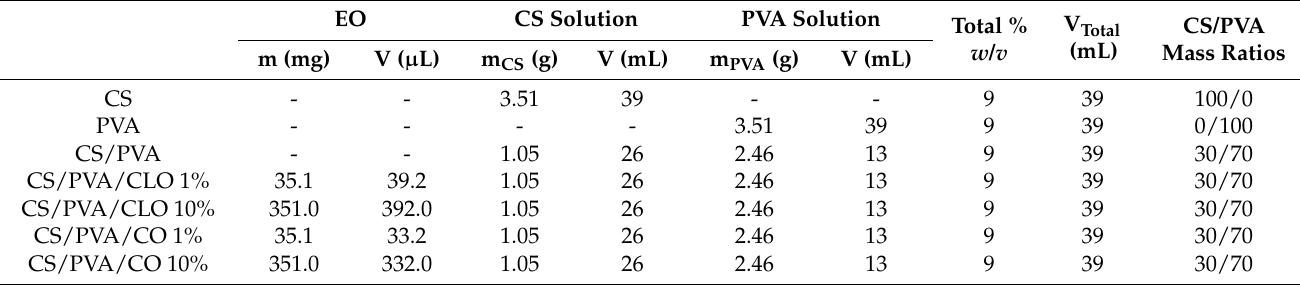
Figure 2. Preparation of EO-loaded CS/PVA blended films. Films were prepared through solvent casting followed by the phase inversion method, combining hydrophilic CS, and PVA to encapsulate hydrophobic EO and, this way, assist in bacterial elimination. After separate polymer dissolution in the adequate solvents, EO was added at 1/10 wt% (in relation to total polymeric mass) to the CS solution, stirred for 10 min, and blended with PVA. The casted mix was refrigerated for bubble removal, heated for solvent evaporation, and neutralized with salt ions in a suitable amount to induce film detachment from the glass. After cleaning in dH 2 O, the loaded CS/PVA/EO films were obtained. Table 2. Data required to build tested CS/EO/PVA blended films, specifically EO loading amount (in μ L), mass (g), and volume (mL) of polymer solutions for each case, total mass percent (% w/v ), total volume (mL), and selected CS/PVA mass ratios.